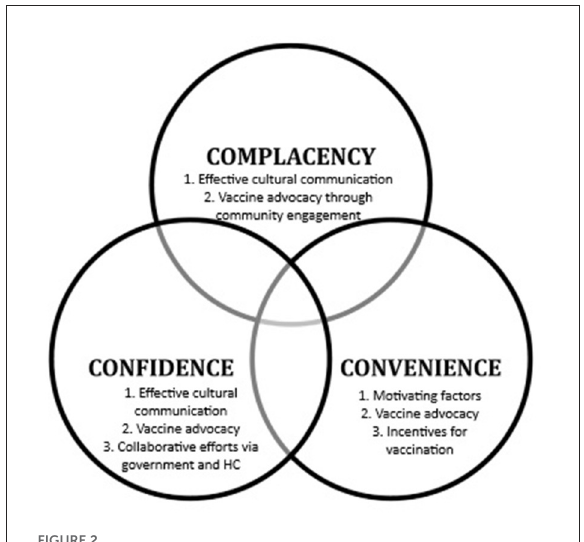
FIGURE2 Factors lowering vaccine hesitancy among immigrants. Figure adapted from “3Cs model of vaccine hesitancy”